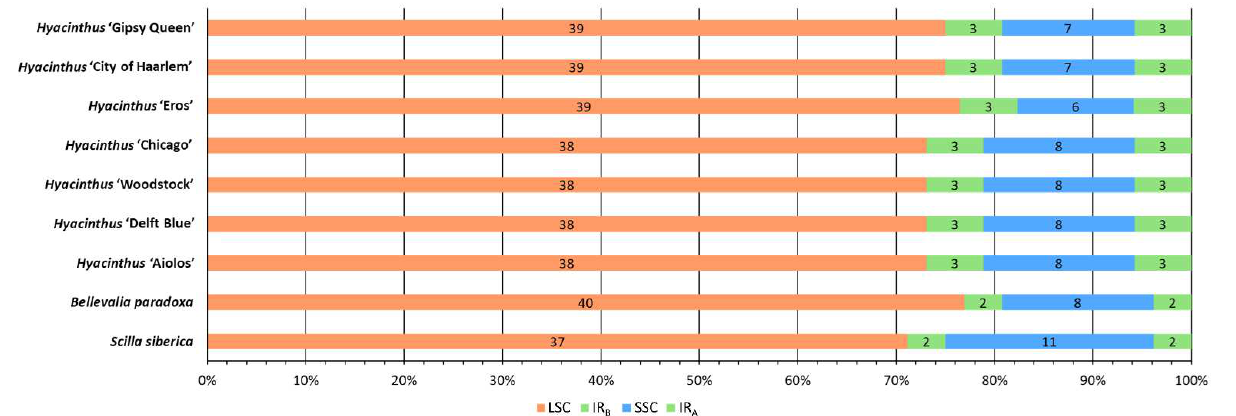
Figure 6. Distribution of SSRs in different partitions of the nine studied chloroplast genomes. The partitions of chloroplast genome were abbreviated as the following: Large Single Copy—LSC; IR B —Inverted Repeat B; Small Single Copy—SSC; IR A —Inverted Repeat A.